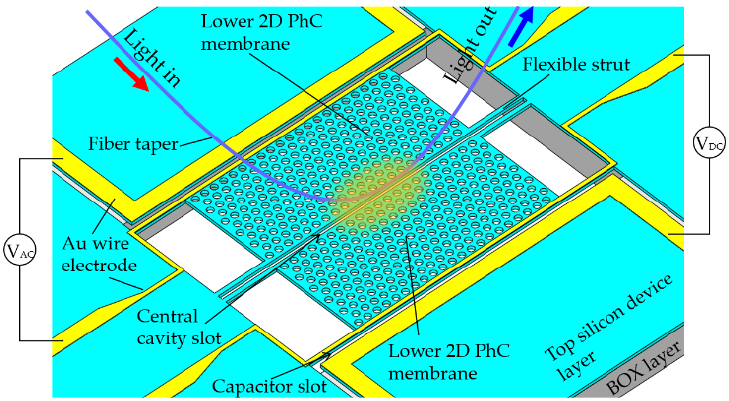
Figure 18. A tunable slotted-waveguide PhC electro-optomechanical cavity [82,122] .